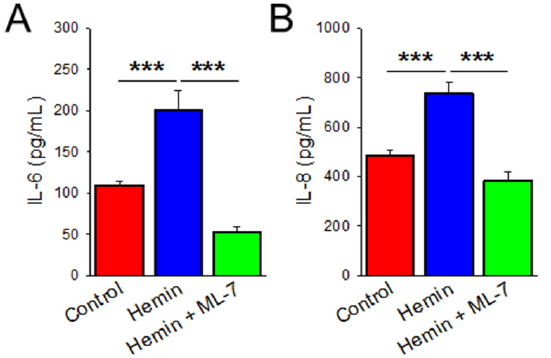
Figure 4. Hemin increases HPAEC cytokine release which is abrogated by MLCK inhibition. Bar graph measuring IL-6 ( A ) and IL-8 ( B ) concentrations in the media of HPAECs treated for 24-h duration with hemin (5 µM), PBS control, and hemin (5 µM) with ML-7 (20 µM) pre-treatment ( n = 6). *** indicates p < 0.001; IL-6, Interleukin-6; IL-8, Interleukin-8; ML-7, myosin light chain kinase specific inhibitor.